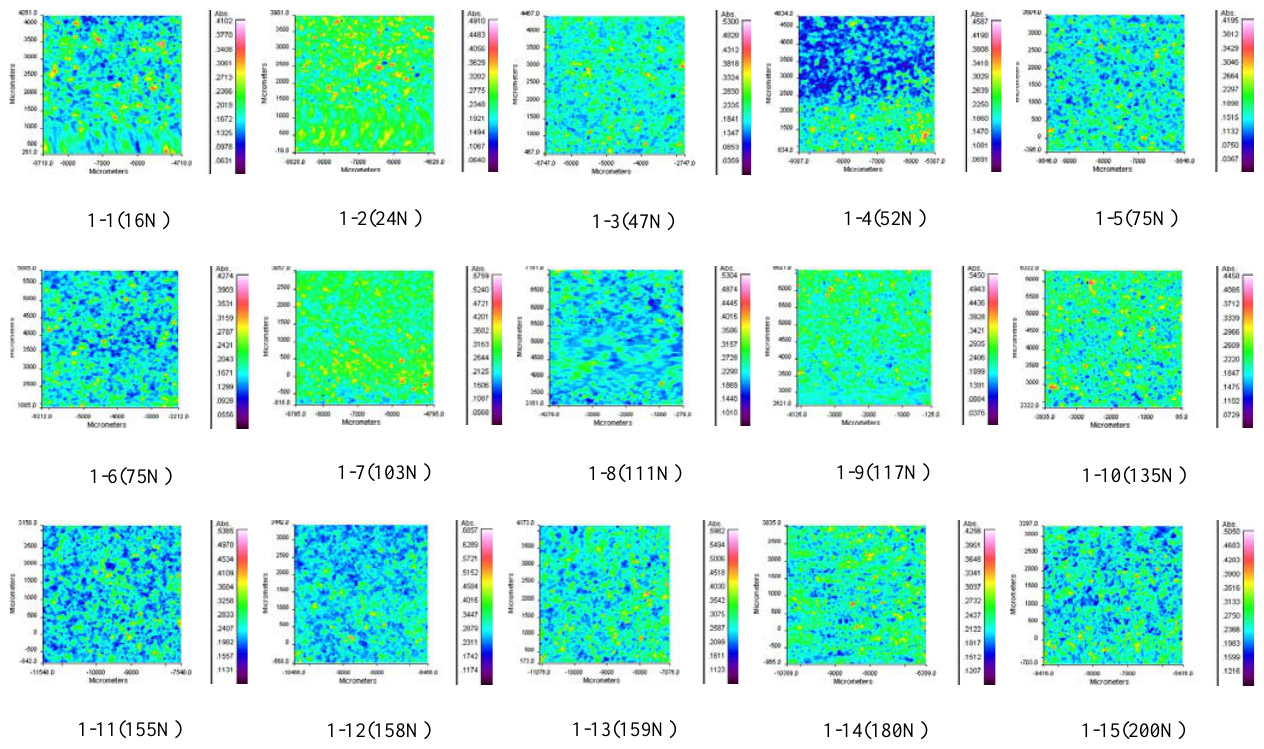
Fig. 1. Raw NIR images of Yinhuang dispersible tablets of di®erent hardness.